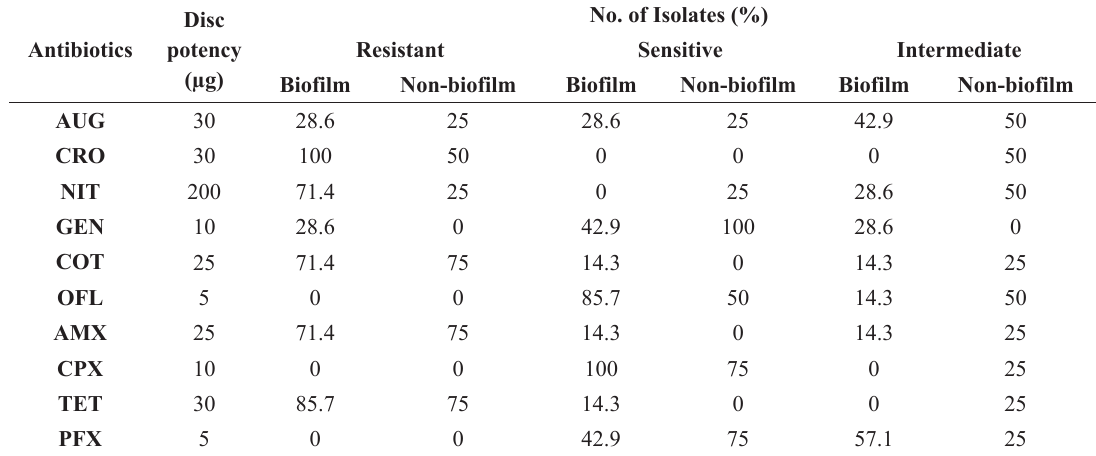
Table 5: Antibiotic susceptibility pattern of the isolates No. of Isolates (%) Disc Antibiotics potency Resistant Sensitive Intermediate (µg) Biofilm Non-biofilm Biofilm Non-biofilm Biofilm